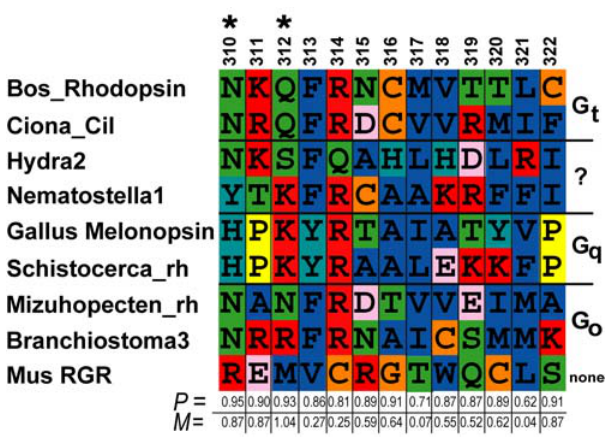
Figure 7. Summary of co-variation analyses and tests for selection. Previously described G protein binding states, together with amino acid sequences of the 4 th cytoplasmic loop regions from our opsin dataset, were used to test the hypothesis that the two character sets co-vary across our opsin phylogeny. Co-variation was assessed using mutual information content (MIC). Shown here is a representation of these results. Predictive P-values (Bottom axis) based on MIC for co-variation between each residue in the 4 th cytoplasimic loop and their respective G protein interactions (Right axis) are shown. These analyses were conducted using Bayesian mutational simulation mapping in SIMMAP [64]. We also tested possibility that these residues had evolved under a selective regime using the criterion of site specific rate heterogeneity as implemented in DIVERGE2 [29]. The two highest scoring residues from co-variation analyses (310 and 312) also retain the signature of selection (asterisk). See table S1 for citations. P =predictive P-value, M =the M statistic given by